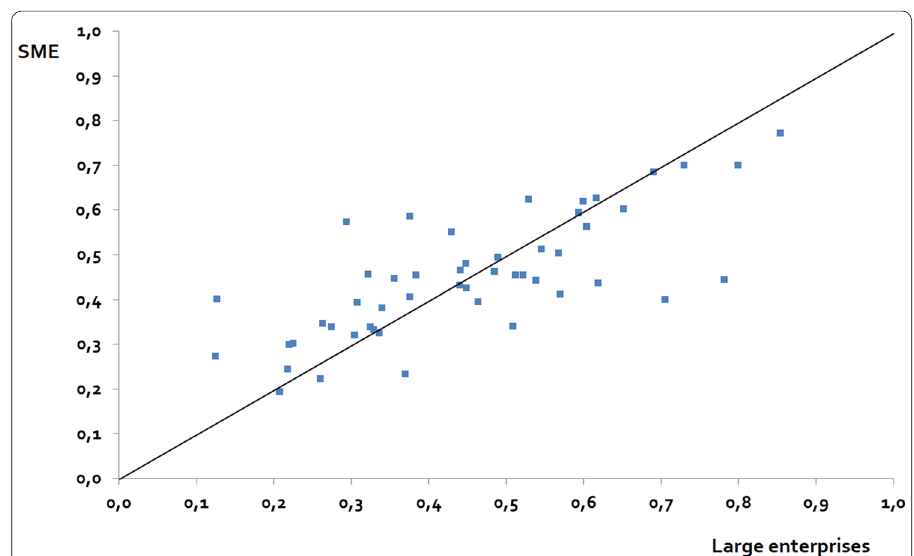
Fig. 3 Own value added embodied in 1 euro of final production, by industry and size class, 2012